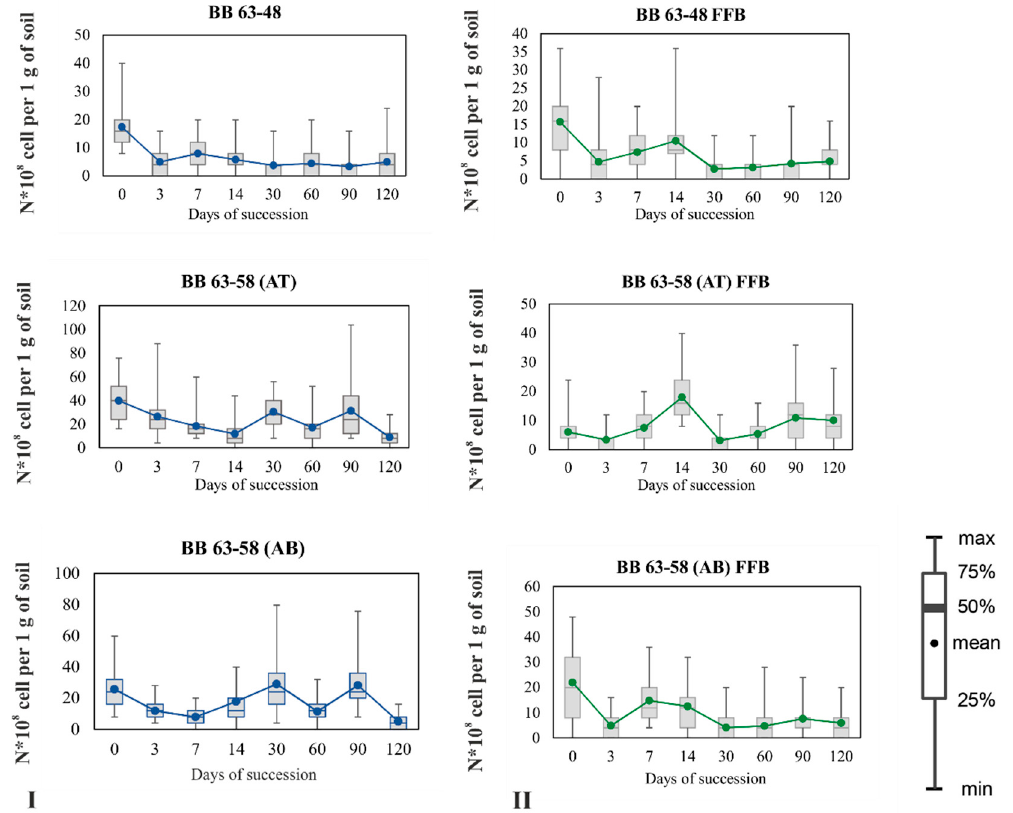
Figure 4. Dynamics of the total number of bacteria and FFB in the studied soils, incubation temperature 20 ◦ C: ( I )—Soil (total cells); ( II )—FFB.